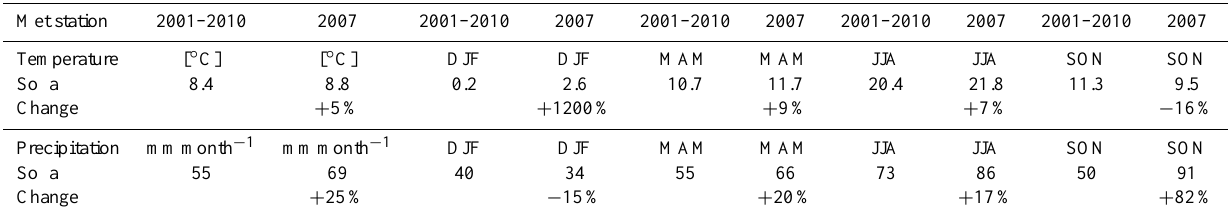
Table 4. Annual and seasonal means of IWV, temperature and precipitation for station Sofia, Bulgaria for winter (DJF), spring (MAM), summer (JJA) and autumn (SON) for 2001–2010 and 2007. Met